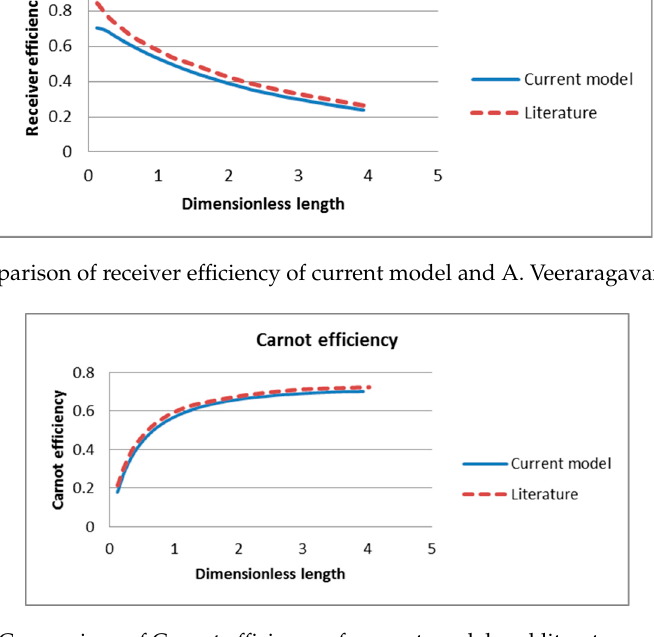
Figure 7. Comparison of Carnot efficiency of current model and literature model [29].